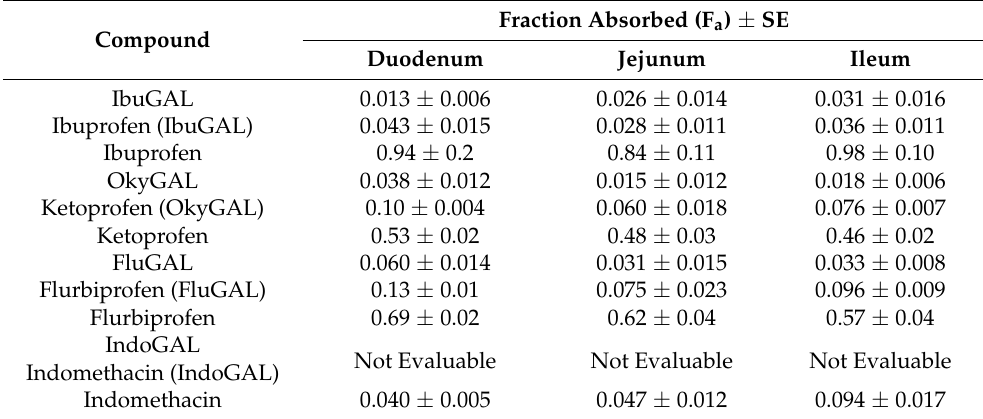
Table 3. Ex vivo fraction absorbed (F a ) of galactosylated prodrugs compared to relative NSAIDs. Compound